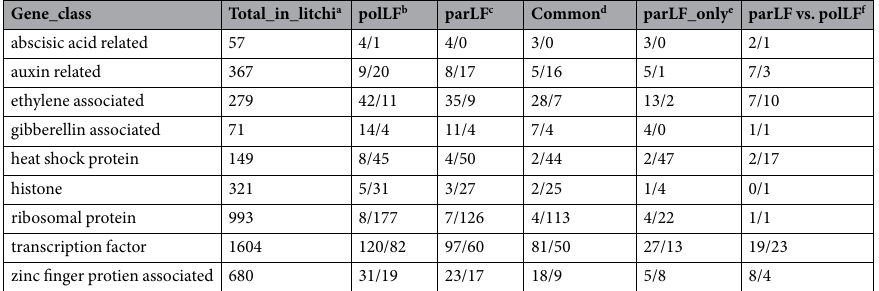
Table 2. Genes commonly up- and down-regualted in polLF and parLF during the early fruit developmental process. a Total number of genes annotated in litchi genome. b Number of DEGs in polLFs, up-regulated/down- regulated. c Number of DEGs in parLFs, up-regulated/down-regulated. d Number of DEGs in both polLFs and parLFs, up-regulated/down-regulated. e Number of DEGs exclusively in parLFs, up-regulated/down-regulated. f Number of DEGs in parLFs compared to polLFs,